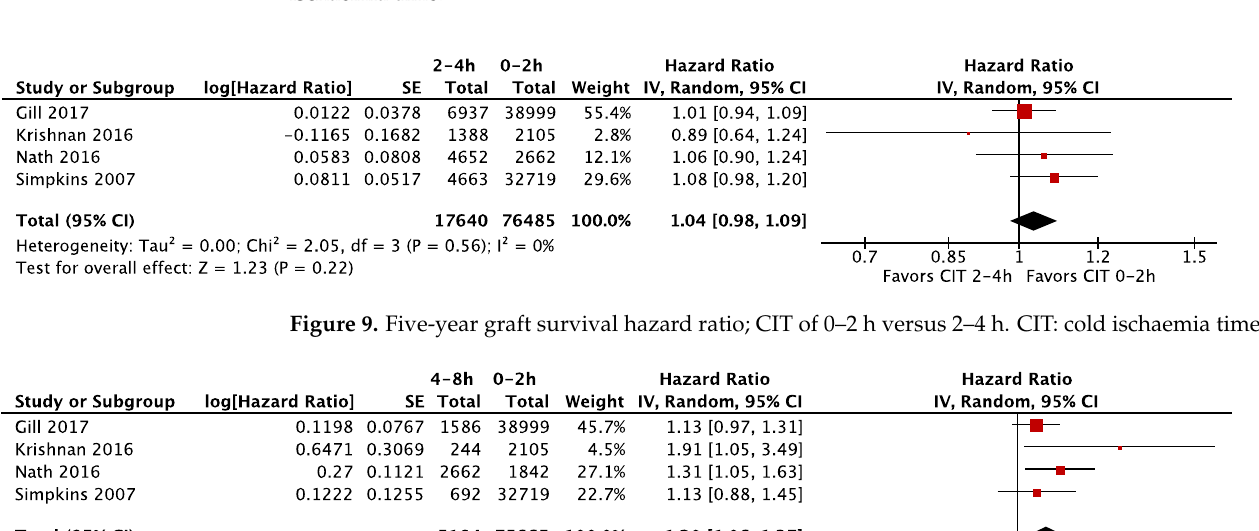
Figure 8. Five-year graft survival; CIT of 0–2 h (reference) versus 2–4 h and 4–8 h of CIT. CIT: cold ischaemia time.